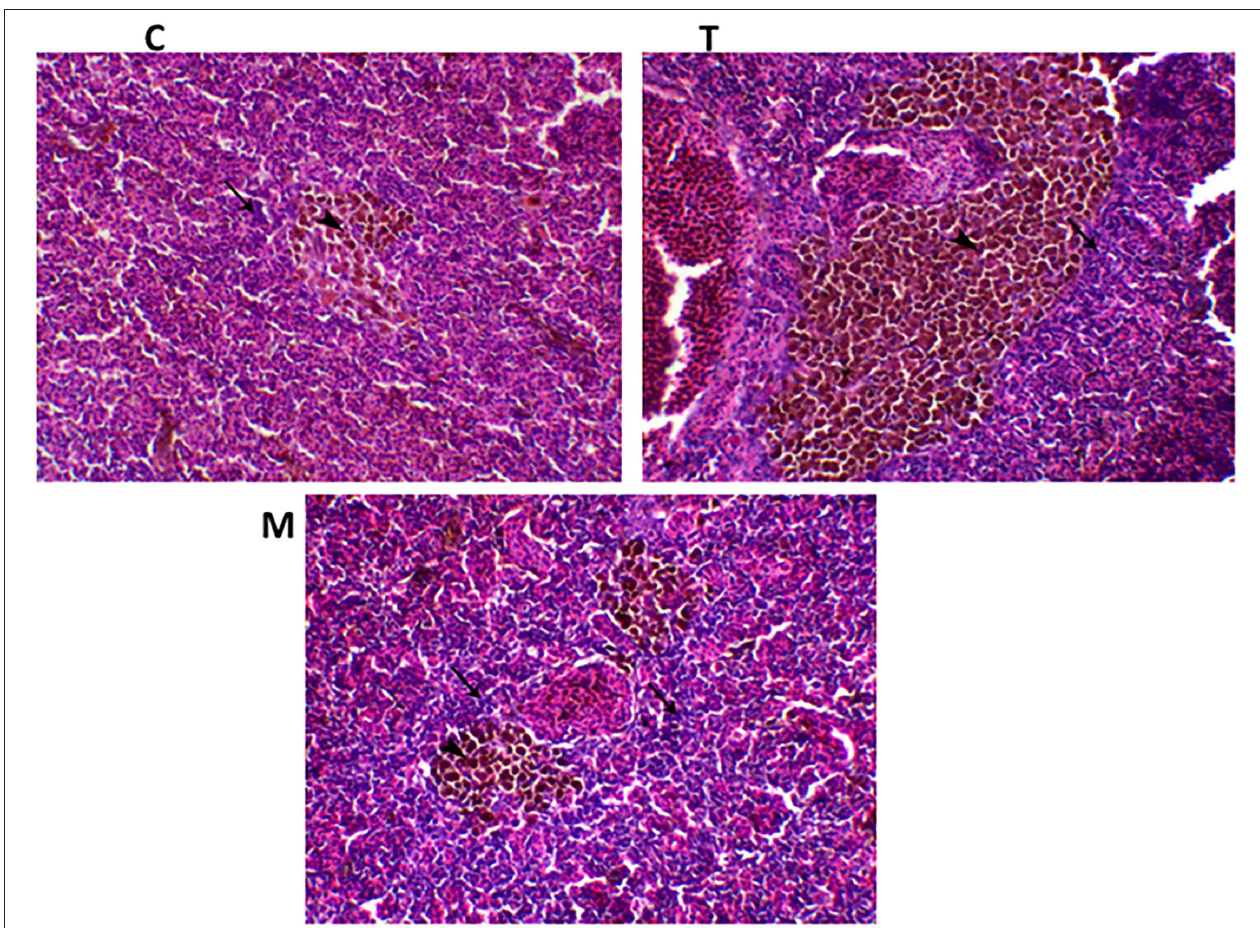
FIGURE 6 | H&E stained spleen of tilapia following dietary inclusion of moringa leaf for 8 weeks under normal health conditions. C, T, and M denote the 0, 5, and 10% moringa levels, respectively. The black arrowhead represents melanomacrophage cells located within the white pulp, while the black arrow represents lymphocytic